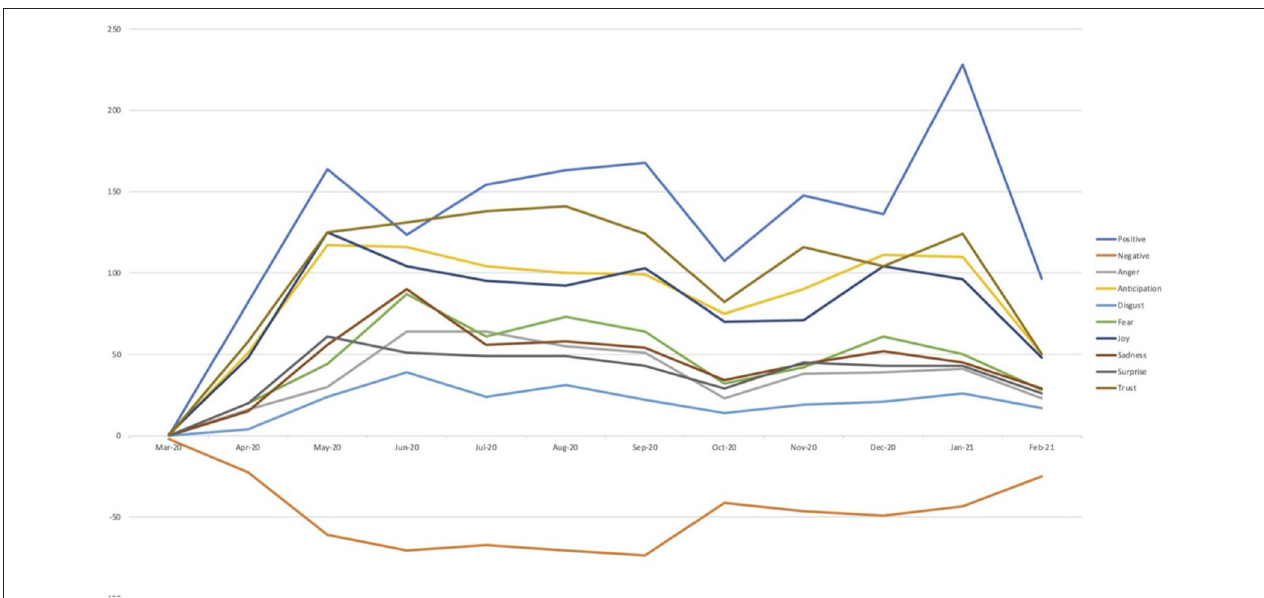
FIGURE 2 | Trend lines depicting the trajectories of decomposed emotions over the examined time